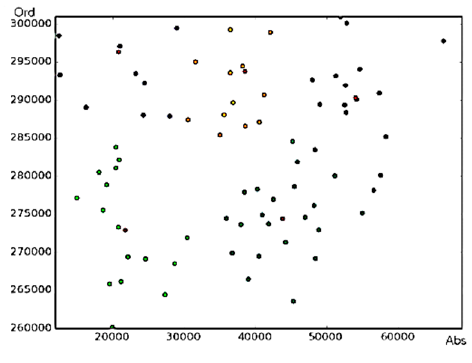
Figure 1. First day clustering.